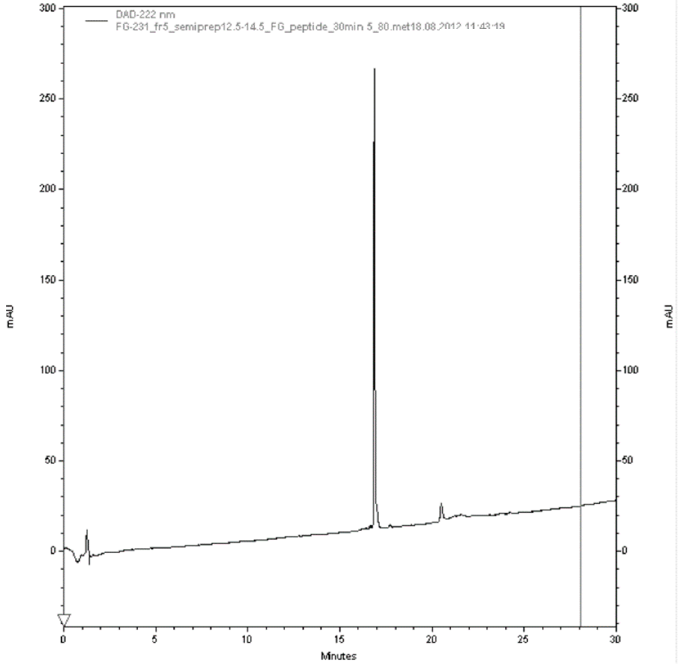
Figure 4. Analytical RP-HPLC trace of 4 after preparative RP-HPLC.